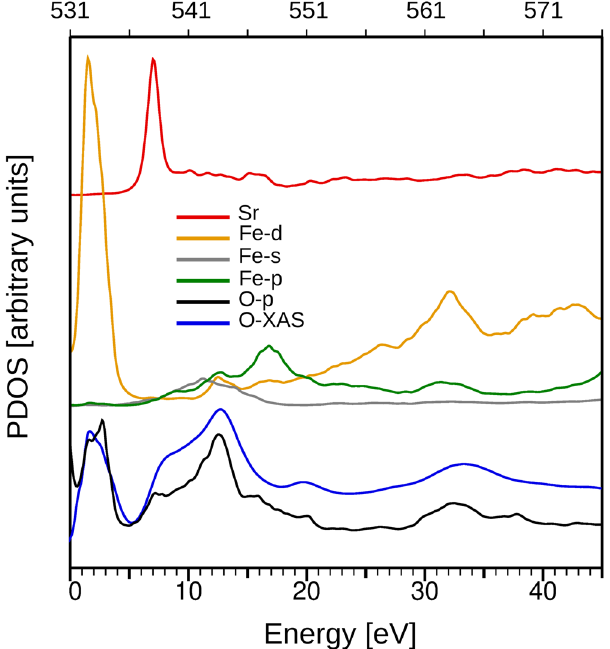
Figure 9. Blue line: X-ray absorption spectrum at the O K absorption edge, recorded at 2 K and an applied magnetic field of 6T from the SFO platelets and averaged for both light helicities. Rest of lines: Calculated density of states projected on the Sr atoms, Fe- d , p and s and the O- p states (see legend). The PDOS curves for each species have been vertically shifted and rescaled for visual inspection.